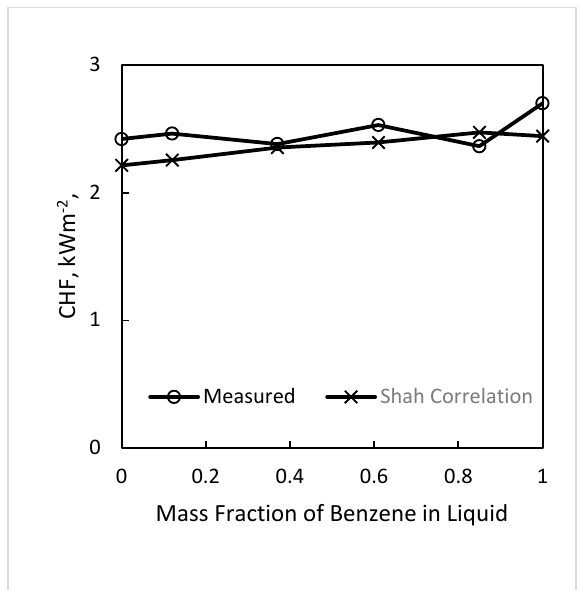
Figure 3. Comparison of the data from Carne (1963) [11] for benzene–toluene mixture in an annulus with the Shah (2015a) [27] correlation. Liquid velocity is 4.36 ms − 1 , inlet subcooling is 80 K, and pressure is 2.23 bar.